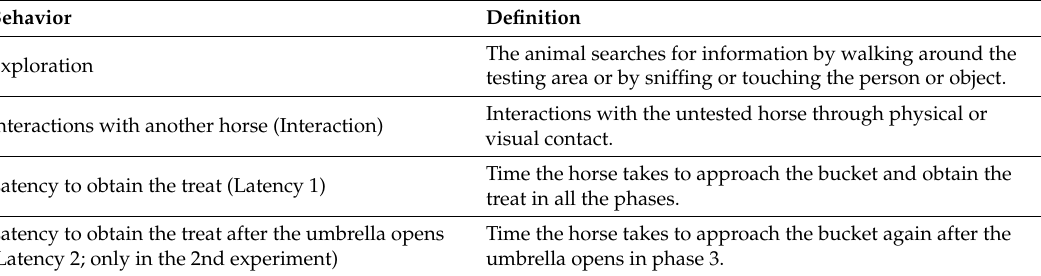
Table 3. Ethogram used for video